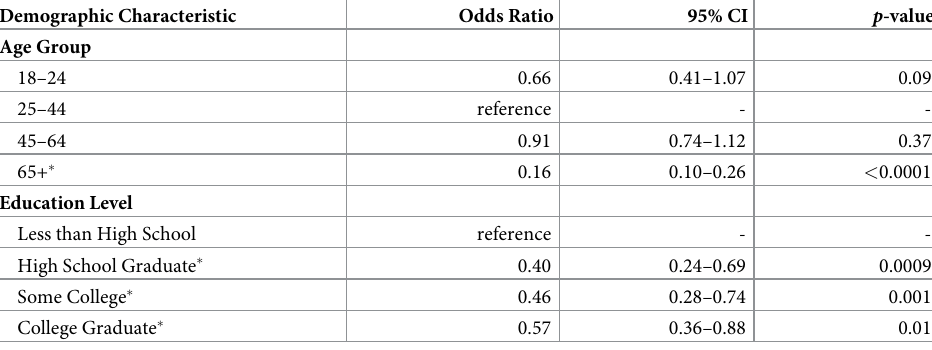
Table 6. Odds of responding to a text invitation 1